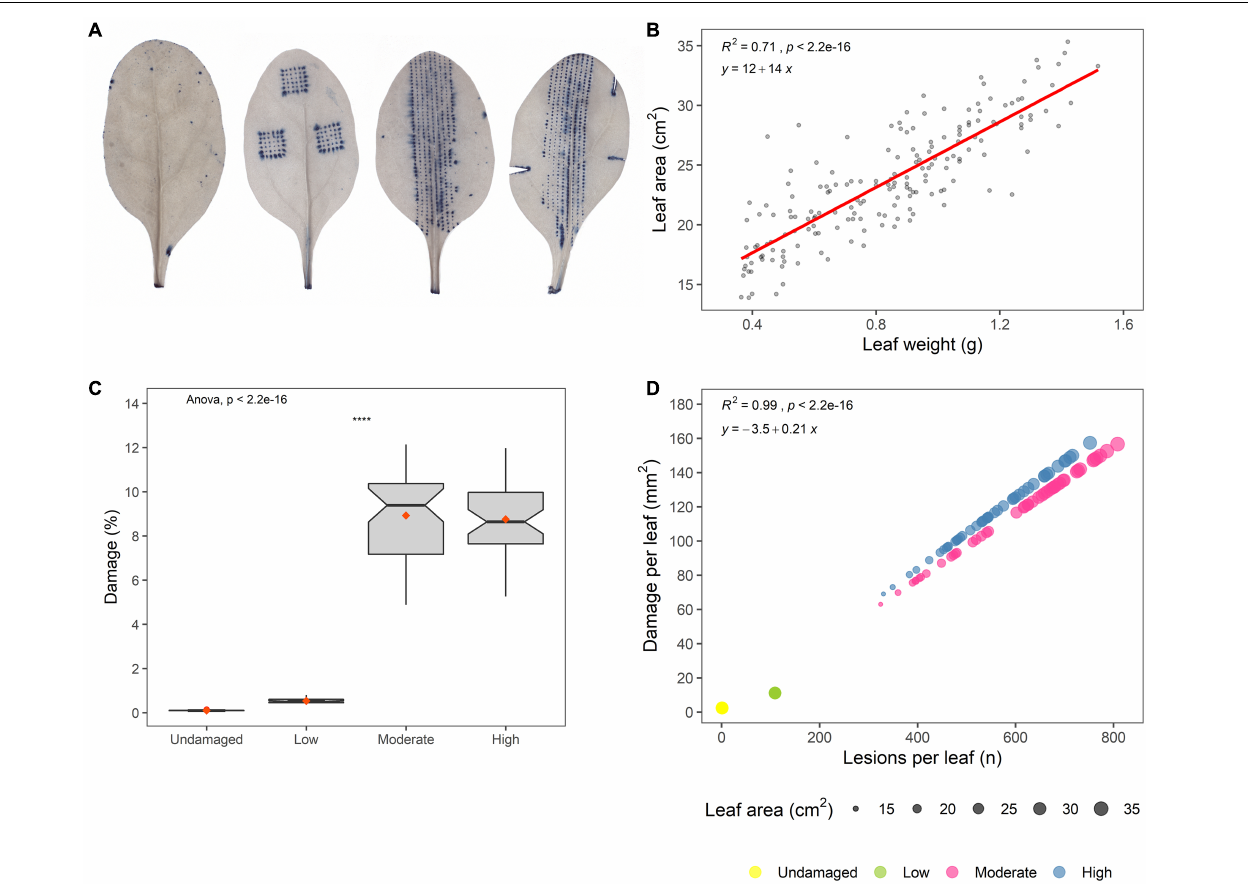
FIGURE 1 | (A) Images of artificially damaged and Trypan blue-stained spinach leaves, visualizing the different levels of standardized artificial damage (from an undamaged leaf on the left to a high-damage leaf on the right). This batch of artificially damaged leaves was used for predictions of damage and number of lesions on E. coli O157:H7 inoculated leaves. (B) Plot of leaf weight (g) against leaf area (cm 2 ), with regression line (red) showing the result of the model: y Leafarea = β 0 + β 1 x Leafweight . (C) Predicted damage per leaf (%) on E. coli O157:H7 inoculated leaves (Wilcoxon test; ns: p > 0.05, * p ≤ 0.05, ** p ≤ 0.01, *** p ≤ 0.001, **** p ≤ 0.0001). (D) Predicted number of leaf lesions plotted against damaged leaf area (mm 2 ) for different damage levels, where point size in scatter plots denotes leaf area of E. coli O157:H7 inoculated